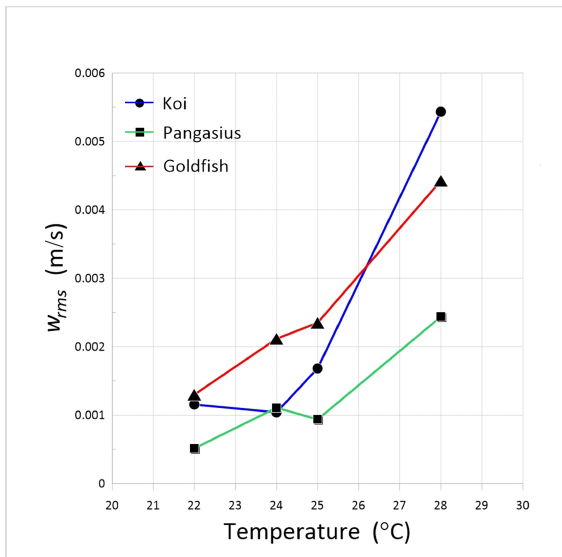
FIGURE 10 RMS velocities of the fl ow generated by the schools of koi, pangasius, and gold fi sh as a function of water temperature.